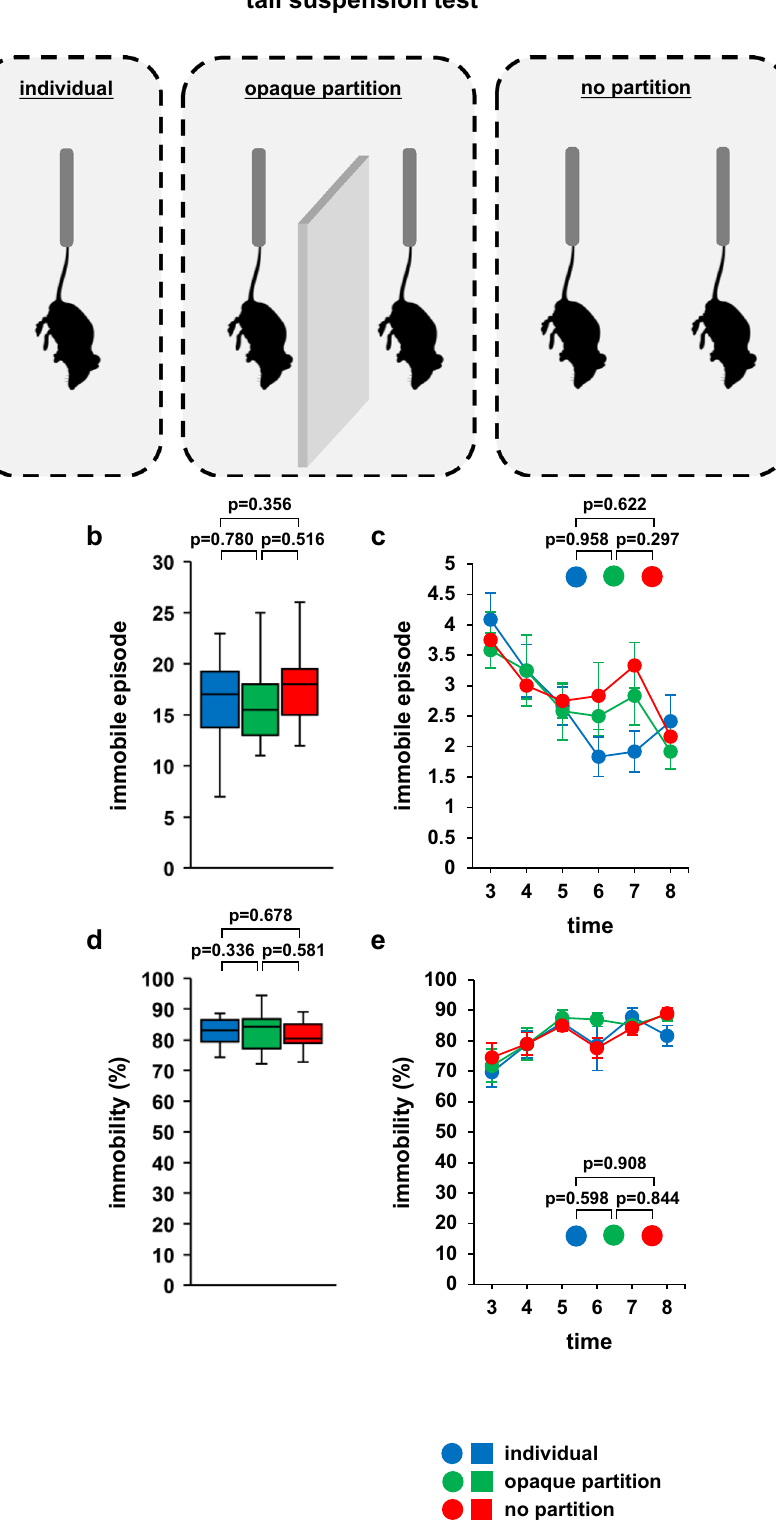
Figure 2. Simultaneous tail suspension testing of two mice. ( a ) Schematic diagram of the experiment. Graphs showing the total number of immobility episodes ( b ) and the immobility episodes during each 1-min period ( c ). Graphs showing the total time spent immobile ( d ) and the proportion of time spent immobile during each 1-min period ( e ). All data are presented as box plots ( b , d ) or means ± standard errors ( c , e ). Statistical significance is represented by asterisks: * p < 0.05, + p < 0.1. The p values were calculated using one-way analysis of variance (analysis of variance [ANOVA] in ( b ) and ( d ) and two-way repeated-measures ANOVA in ( c ) and ( e ). SEM: standard error of the mean. individual: n = 10, opaque partition: n = 10, no partition: n = 10. Respective mean and SEM are listed in Table